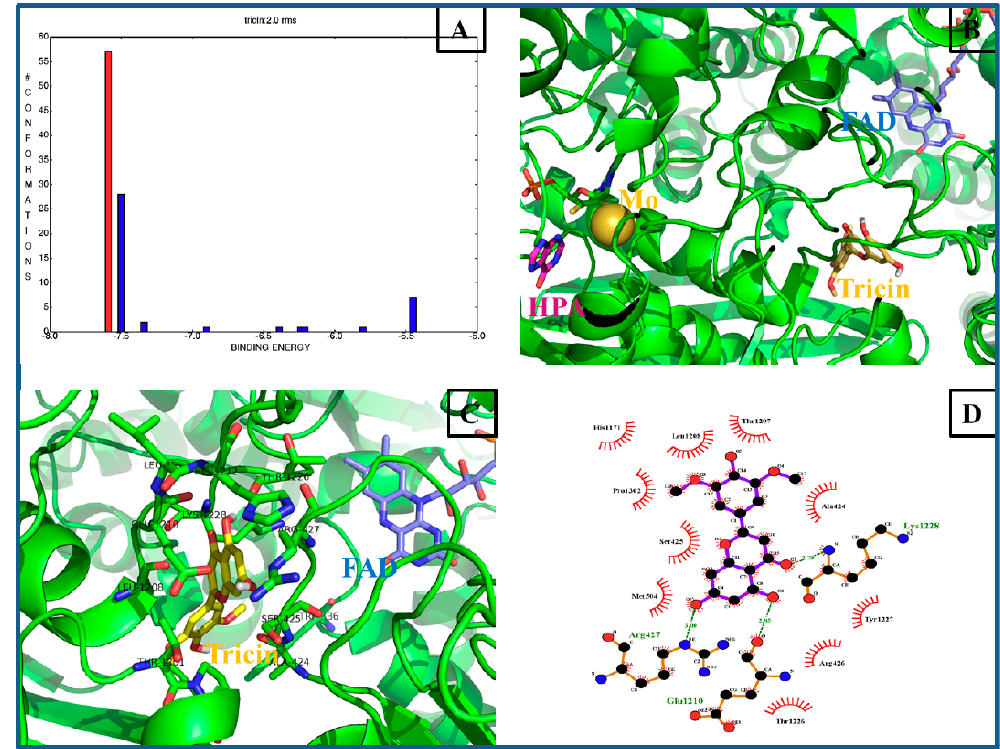
Figure 6. Molecular docking results of tricin to XO. ( A ) Cluster analyses of the AutoDock docking runs of tricin with 3NRZ. ( B ) The binding active positions of hypoxanthine and tricin with 3NRZ. ( C ) Analysis of docked tricin bound to 3NRZ showing the key interactions in the binding pocket. ( D ) Ligplot of tricin bound to 3NRZ showing the key H-bonds (<3 Å) and hydrophobic interactions.